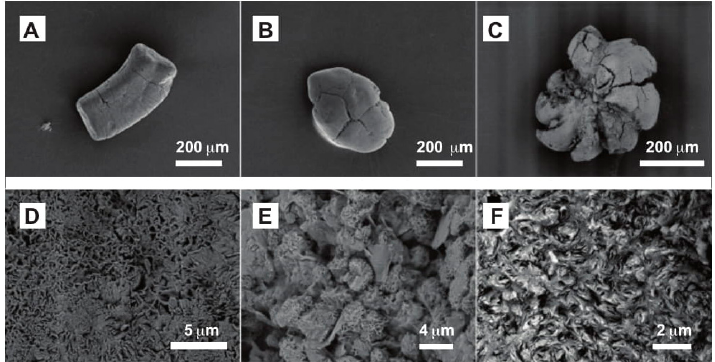
Figure 2. SEM images of glaucony grain surfaces and nanostructures of glaucony crystallites: ( A ) Vermicular grain with near parallel surface cracks—Ross Farm, ( B ) rounded pellet with surface cracks—Campbell’s Beach, ( C ) benthic foraminifera—Gee’s Beach, ( D ) ill-defined globules and caterpillar like structures showing aggregate nature of glaucony growth—Waipara greensand, ( E ) well developed plates and rosette structures of mature glaucony with co-precipitation of less mature crystals—dark green pellet from Campbell’s Beach, ( F ) lamellar structures in highly evolved glaucony.